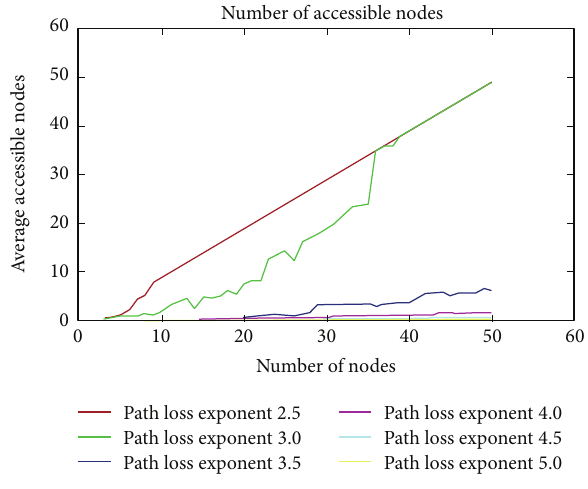
Figure 9: Path loss